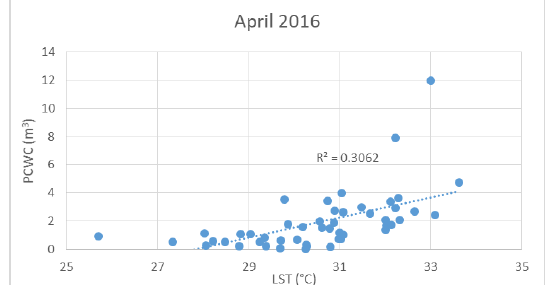
Figure 10. Correlation of LST and PCWC for the month of April, 2017